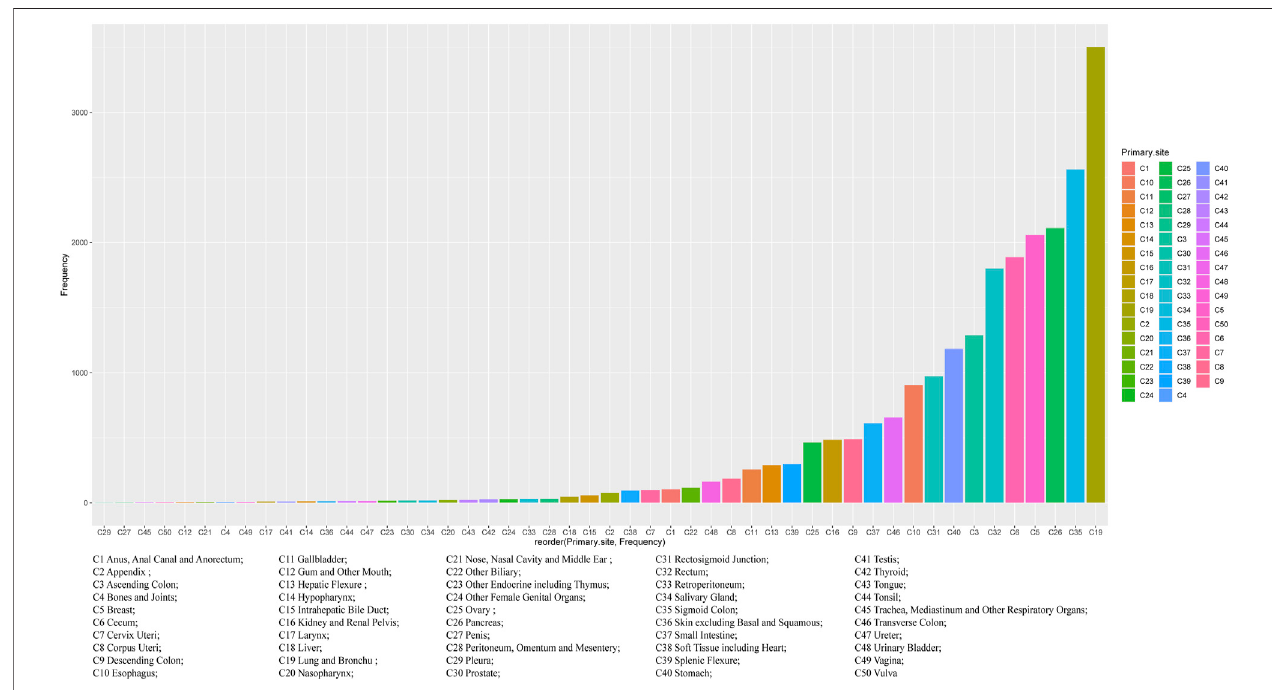
FIGURE 2 | Frequency Distribution of primary tumour sources of hepatic metastatic carcinoma.